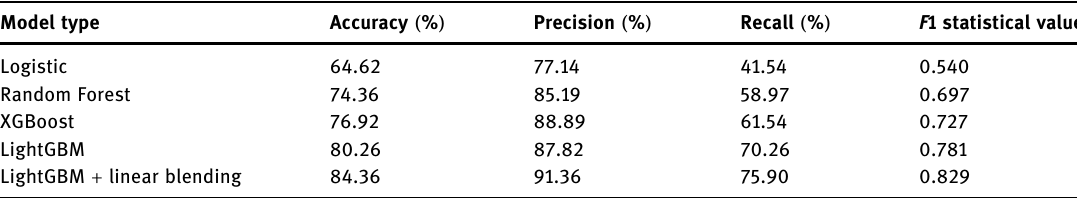
Table 3: Predictive e ff ects of several models